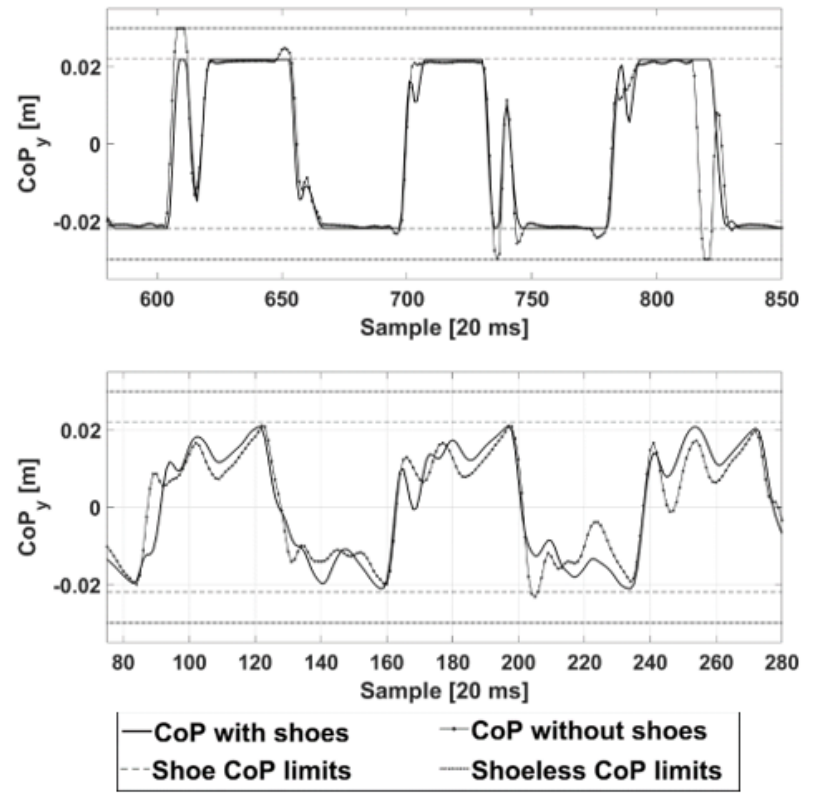
Figure 12. Lateral CoP trajectory comparison between the factory default gait (top) and the HRSP gait (bottom). The trajectories were simulated with and without the instrumented